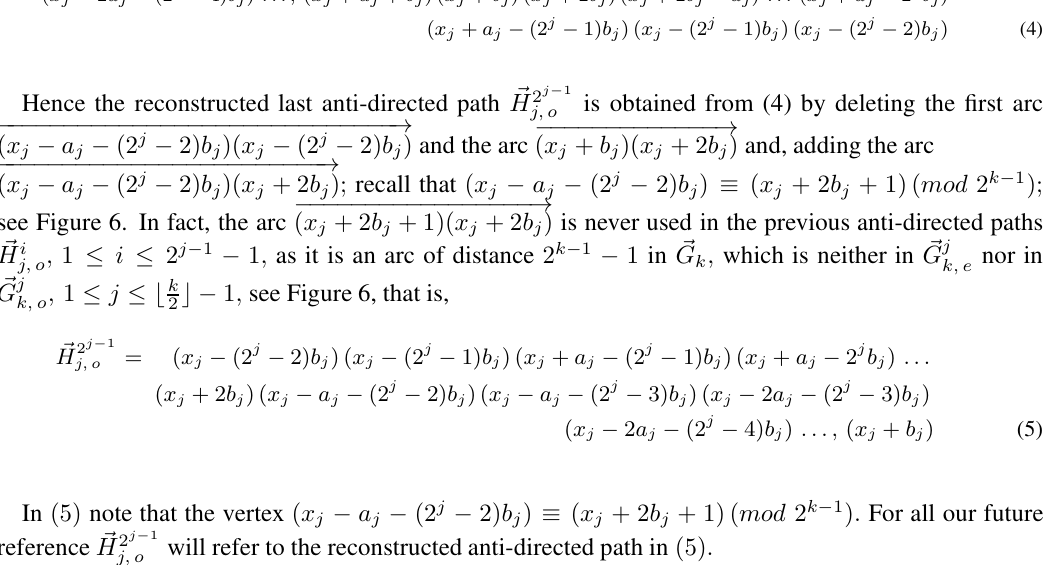
is x j + 2 b j ; therefore, ~C 2 j − 1 j,o